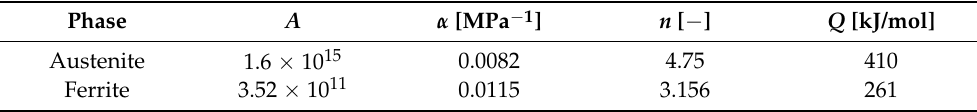
Figure 8. ( a ) Basic true stress vs. true strain curves calculated from different material condition combinations and averaged curves for ferrite and austenite. ( b ) Mean single-phase basic stress-strain curves and single-phase curves considering mean phase distance, as well as stress-strain curves for duplex material with 57% ferrite from experiment and duplex model. Table 5. Input parameters for the Zener–Hollomon equation from the literature, data from [2], for single-phase austenite and ferrite to validate the single-phase results of the duplex